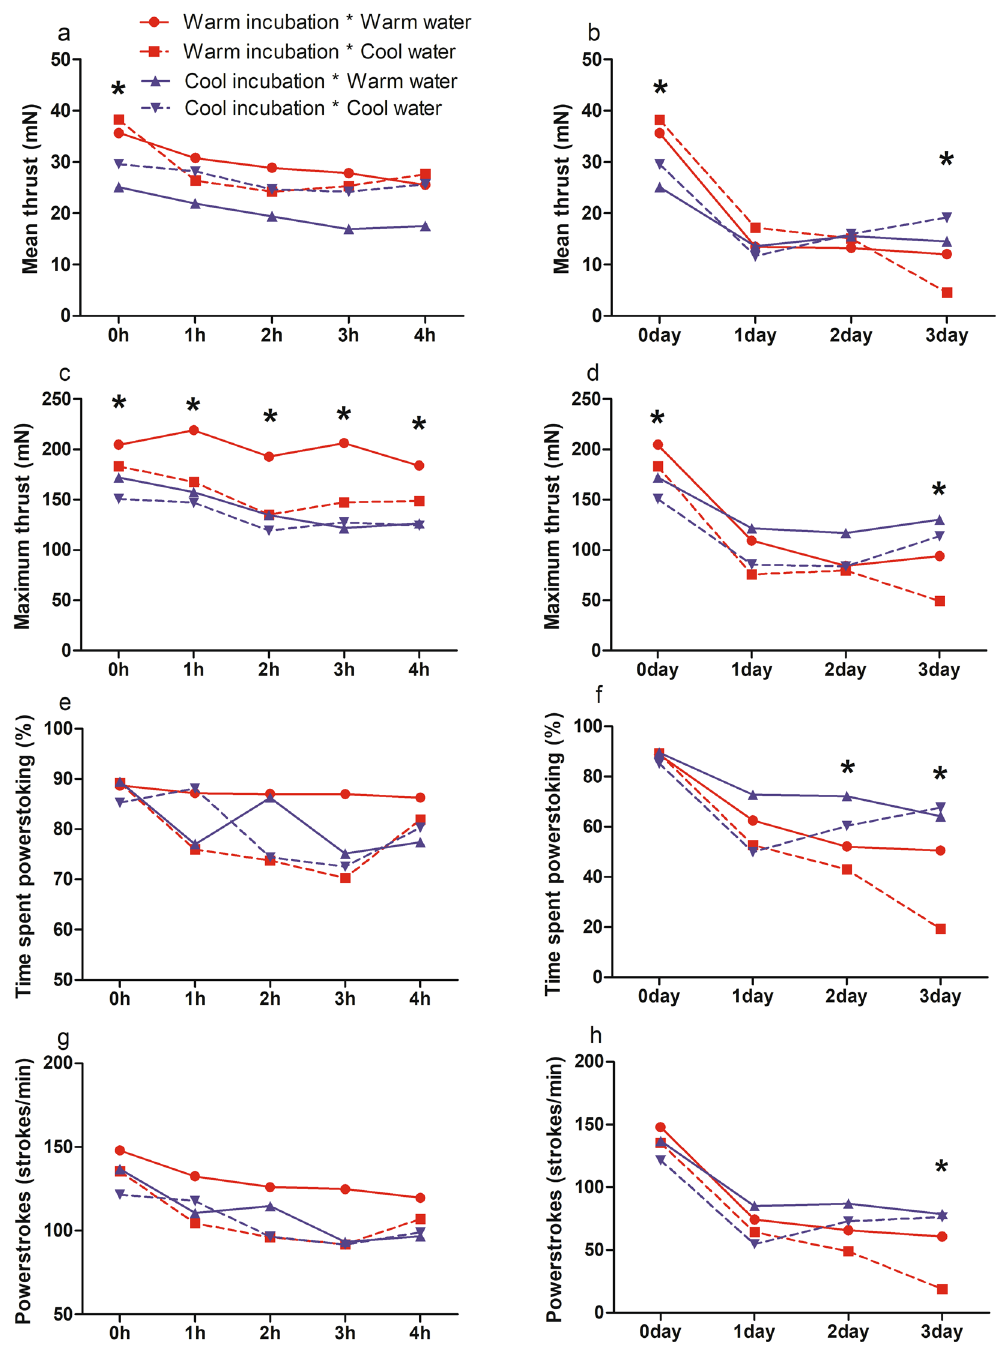
Figure 1. The effect of incubation temperature and water temperature on the swimming performance of loggerhead sea turtles (n = 12 for each group). ( a ) Mean thrust from 0 h to 4 h and ( b ) 0 d to 3 d (72 h). ( c ) Maximum thrust from 0 h to 4 h and ( d ) 0 d to 3 d (72 h). ( e ) Time spent powerstroking from 0 h to 4 h and ( f ) 0 d to 3 d (72 h). ( g ) Number of powerstrokes from 0 h to 4 h and ( h ) 0 d to 3 d (72 h). Results are expressed as means; asterisk indicates that the effect of incubation temperature on the swimming performance was statistically